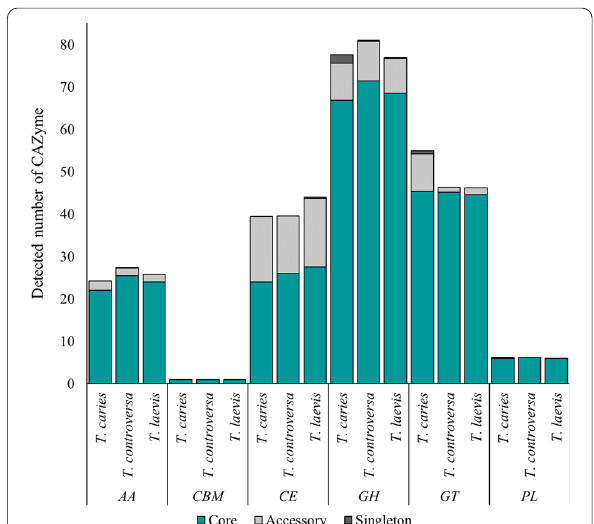
Fig. 8 Distribution of putative CAZymes in the shared and variable orthology clusters, and singleton genes between five isolates of T. caries , seven isolates of T. controversa , and four isolates of T. laevis . The majority of the CAZymes are conserved and shared between the three species. Glycoside Hydrolases (GHs), Polysaccharide Lyases (PLs), Carbohydrate Esterases (CEs), Glycosyltransferases (GTs), Auxiliary Activities (AAs), and Carbohydrate-Binding Modules